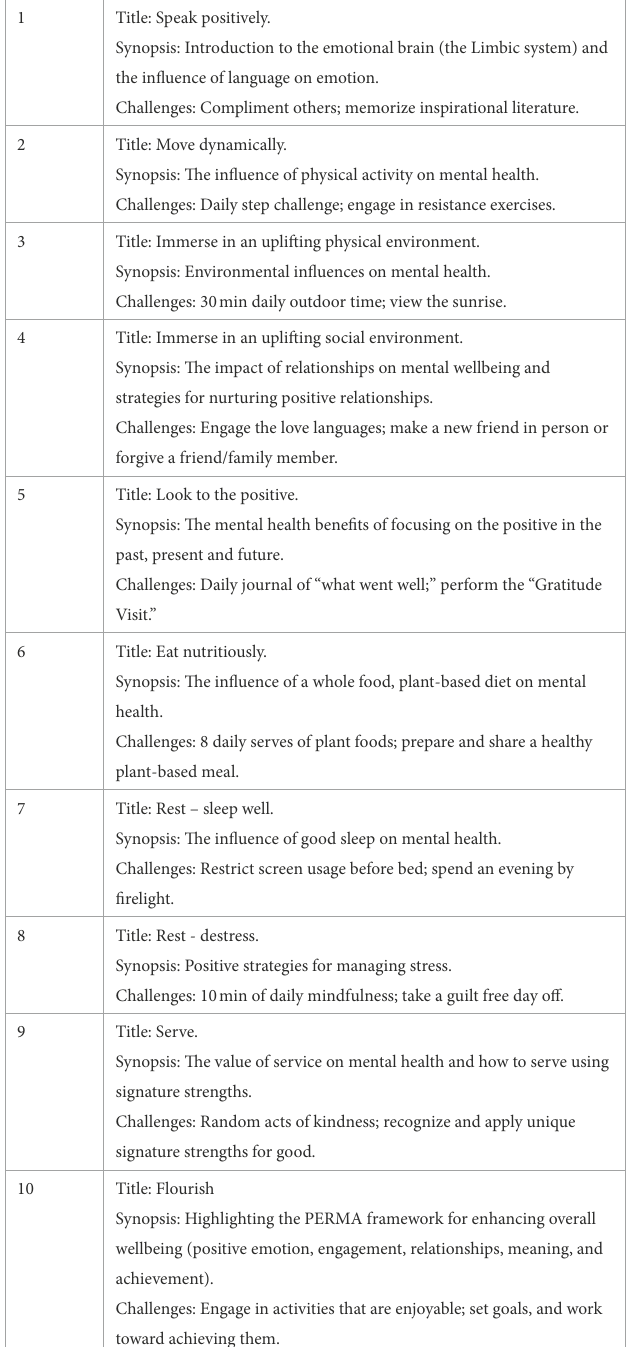
TABLE 1 Overview of The Lift Project intervention.